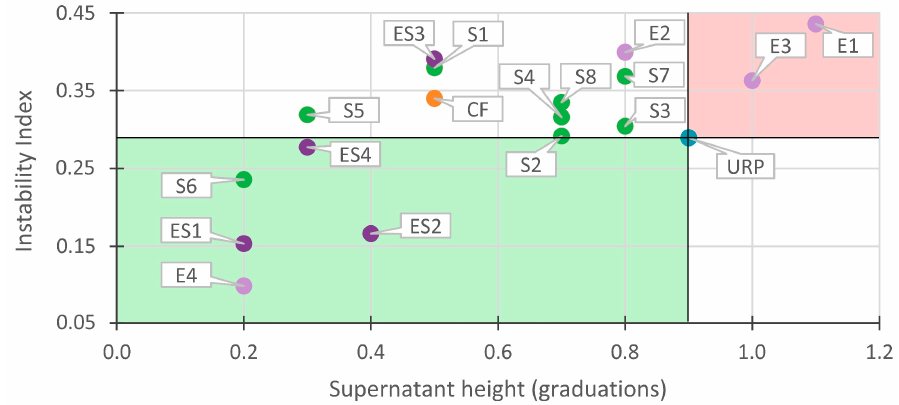
Figure 11. Correlation between the instability index and supernatant height in URP with 1% of dispersing agents. Refer to Tables 1–4 for dispersing agent labels. Green area = positive impact on stability, red area = negative impact on stability.